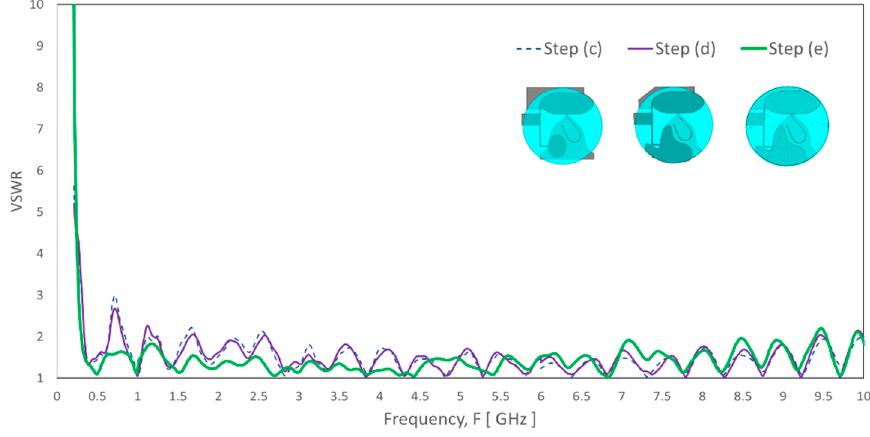
Figure 7. The simulated VSWR of the evolution steps from Figure 4: Step (c) to Step (e).